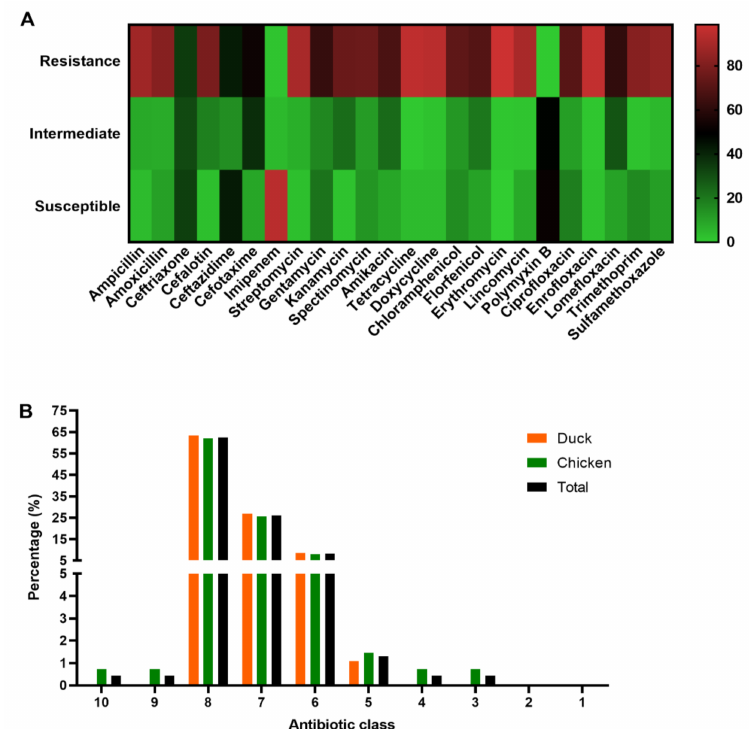
Figure 5. Antibiotic susceptibility testing. ( A ) Information of the antibiotic susceptibility testing (negative, weak, moderate, and strong) profiles of the 230 APEC isolates. ( B ) Prevalence of the MDR of 230 APEC isolates from chickens ( n = 137) and ducks ( n = 93). Bar charts show the frequency rates of MDR from chicken (green), duck (orange) and total